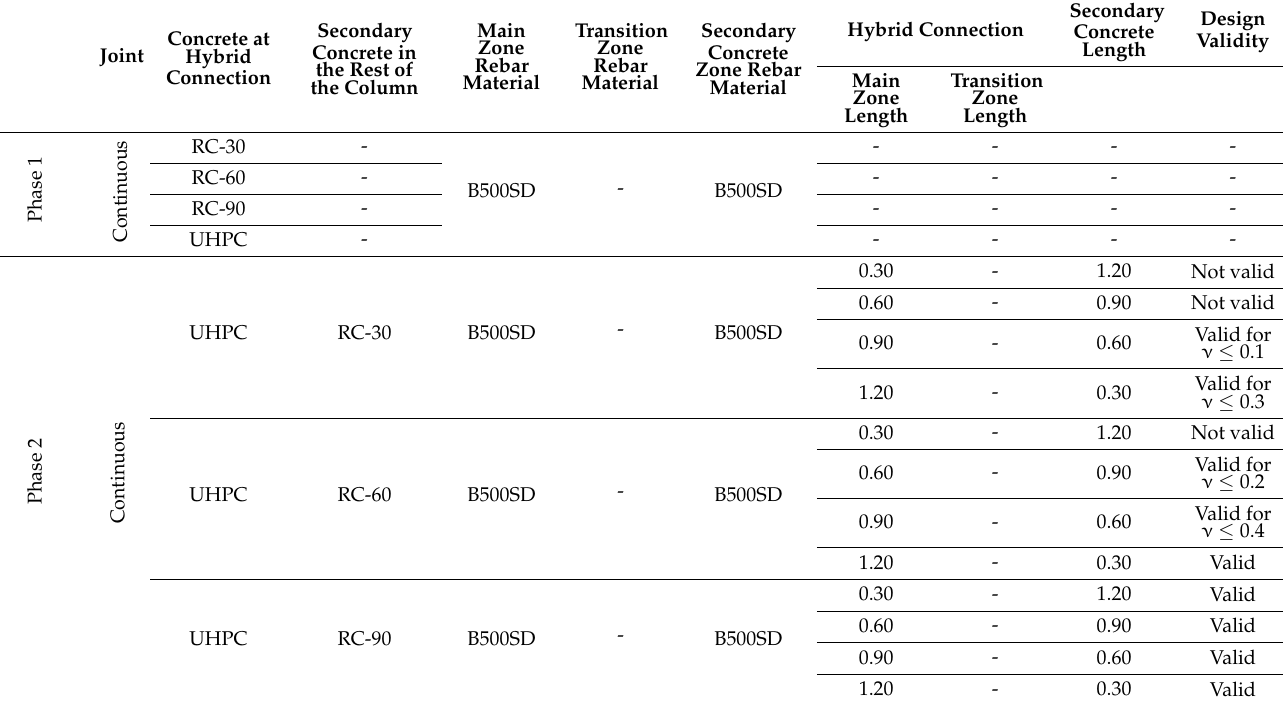
Table 6. Parametric